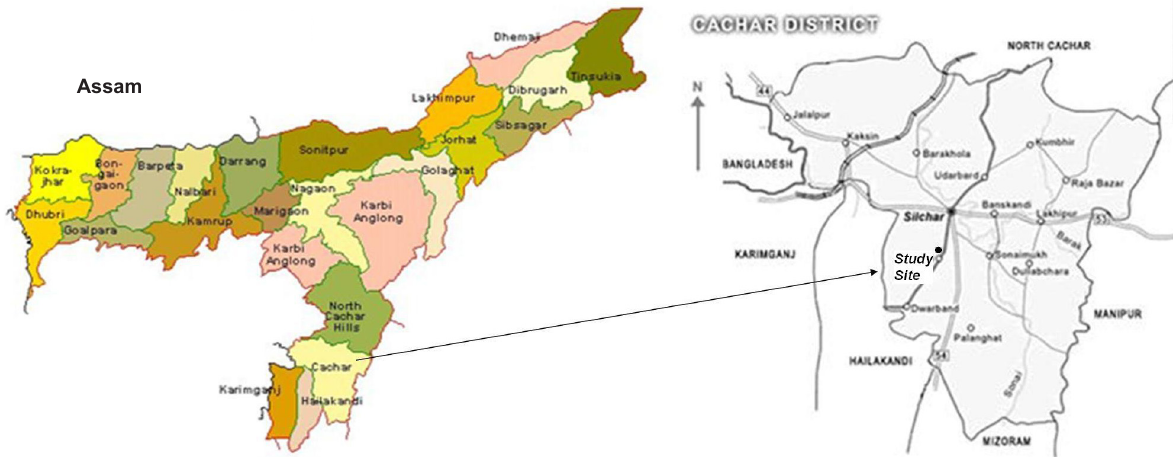
Figure 1. Map of Cachar District, Assam, India showing the location of the Bharambaba temple